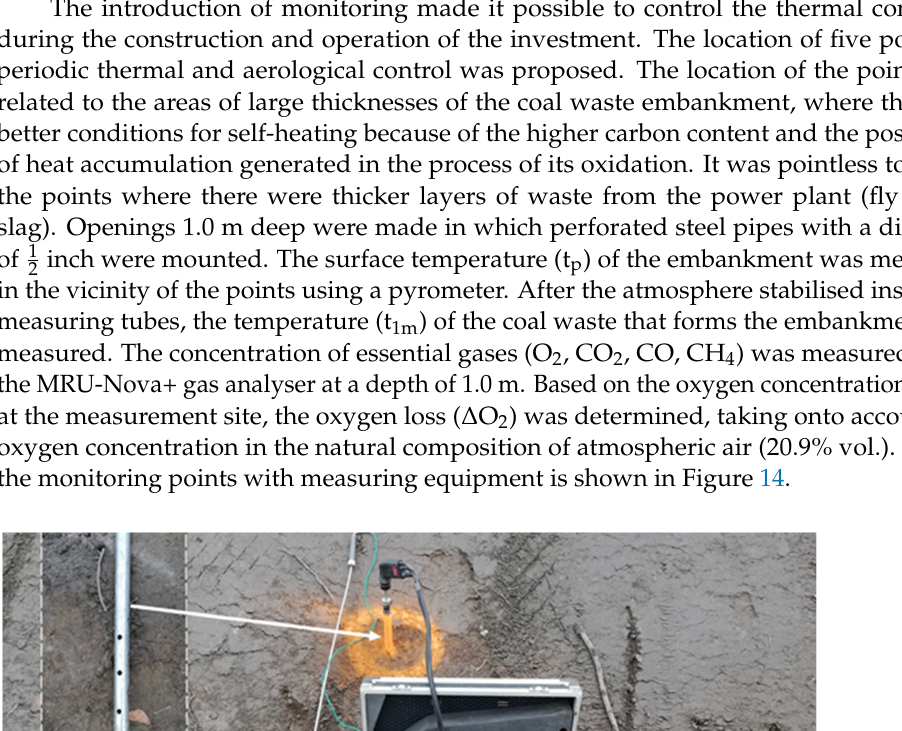
Table 2. Measurement result during the 1st measurement session (own elaboration).